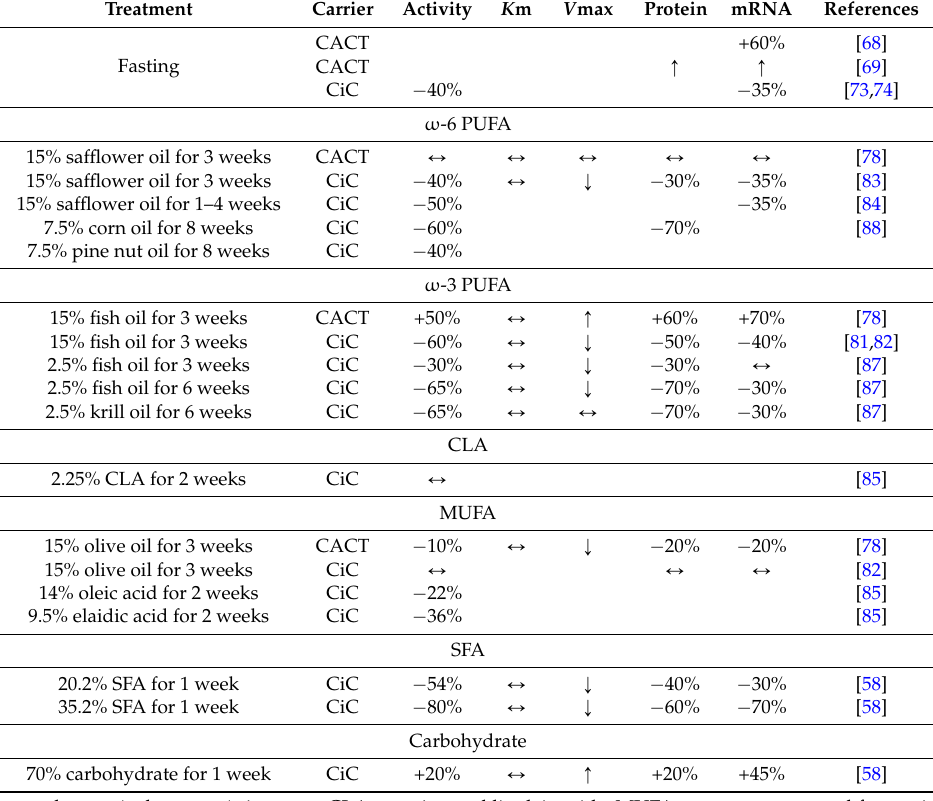
Table 2. Effect of the nutritional status on activity, kinetics, protein and mRNA levels of CACT and CiC. Treatment